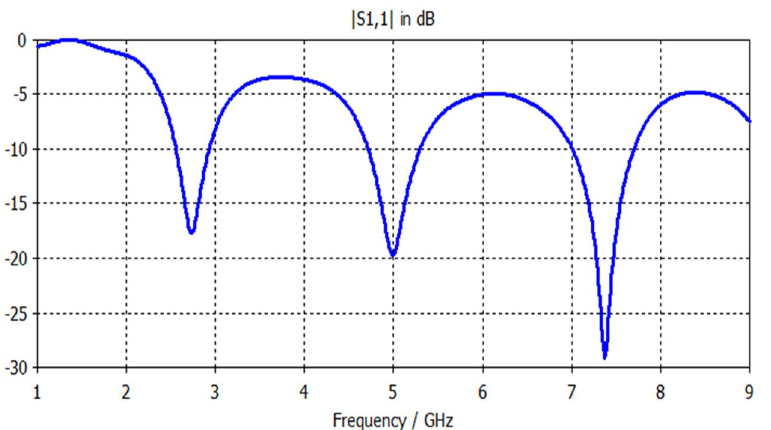
Figure 8. S11 response of